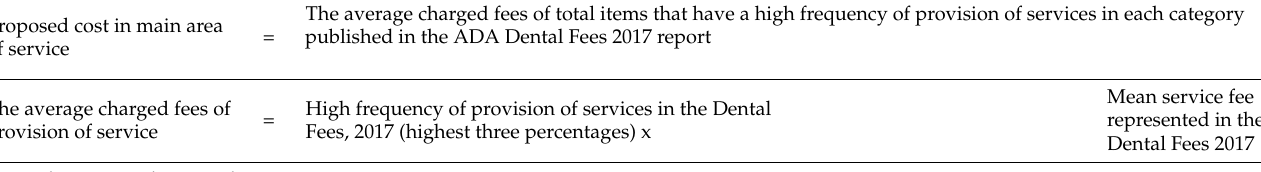
Table 2. The calculation method to obtain the proposed cost in the main area of